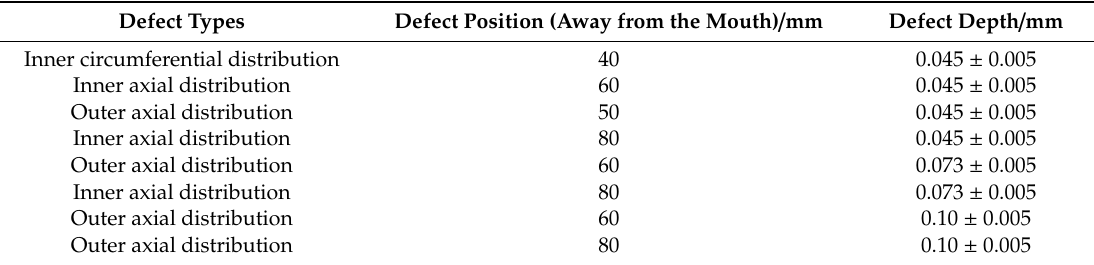
Table 1. Artificial defects of di ff erent